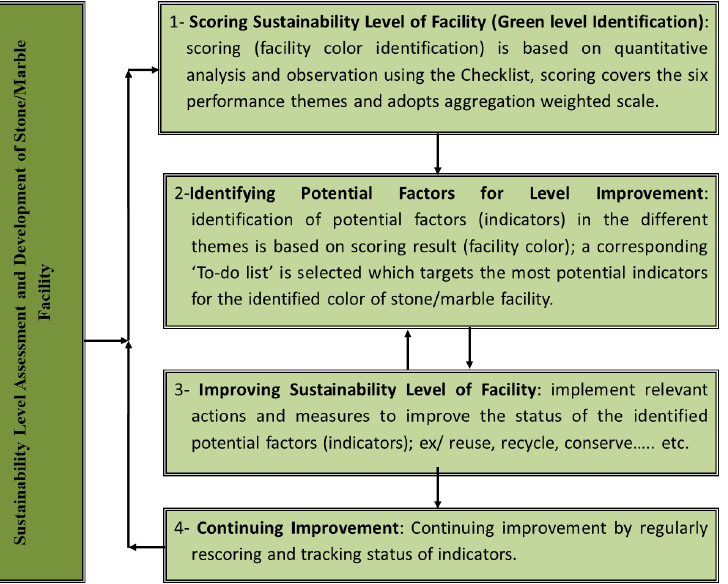
Fig. 2. Sustainability assessment and improvement model for the Palestinian stone and marble industry tent, document local best practices, track life cycle of typical products, and collect data on actually achieved targets of potential indicators. Moreover, identified indicators were classified into compulsory (required) and optional indica- tors, themes and optional indicators were given